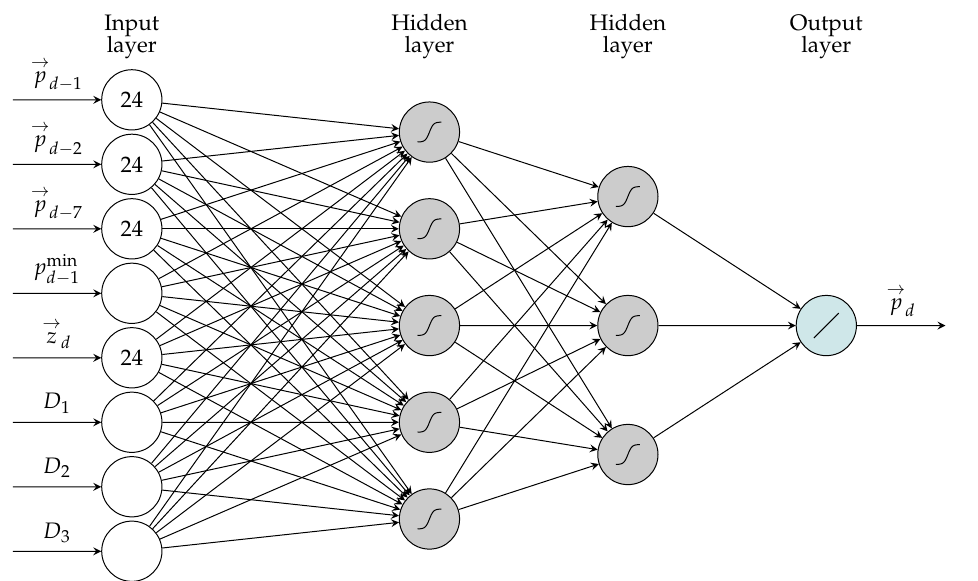
Figure 2. Visualization of the Deep Neural Network (DNN) structure, used in both the DNN benchmark and the main DNN models (hidden layer sizes are not reflected here; the net used in the study comprised 100 neurons in each hidden layer). The arrows over symbols correspond to 24 separate input/output neurons, with a dense connection